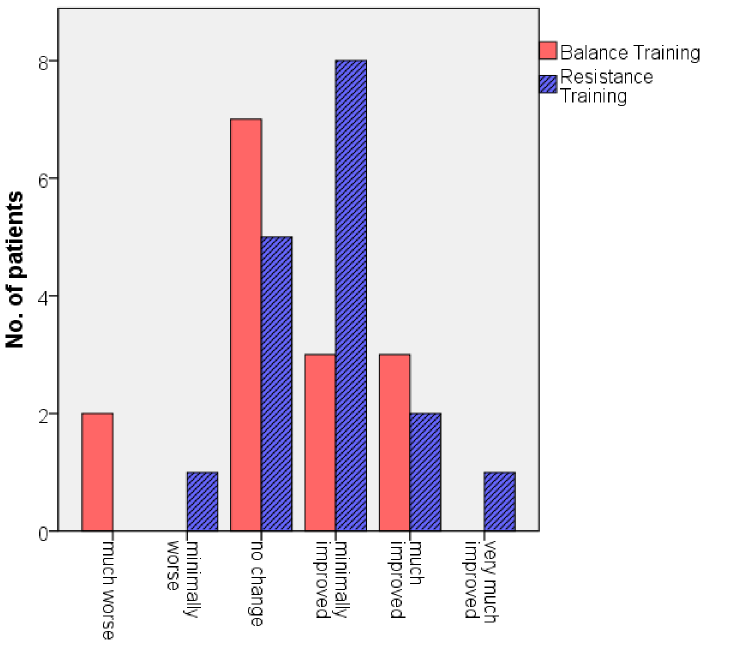
p -value b (between group comparison, baseline to 12-wk